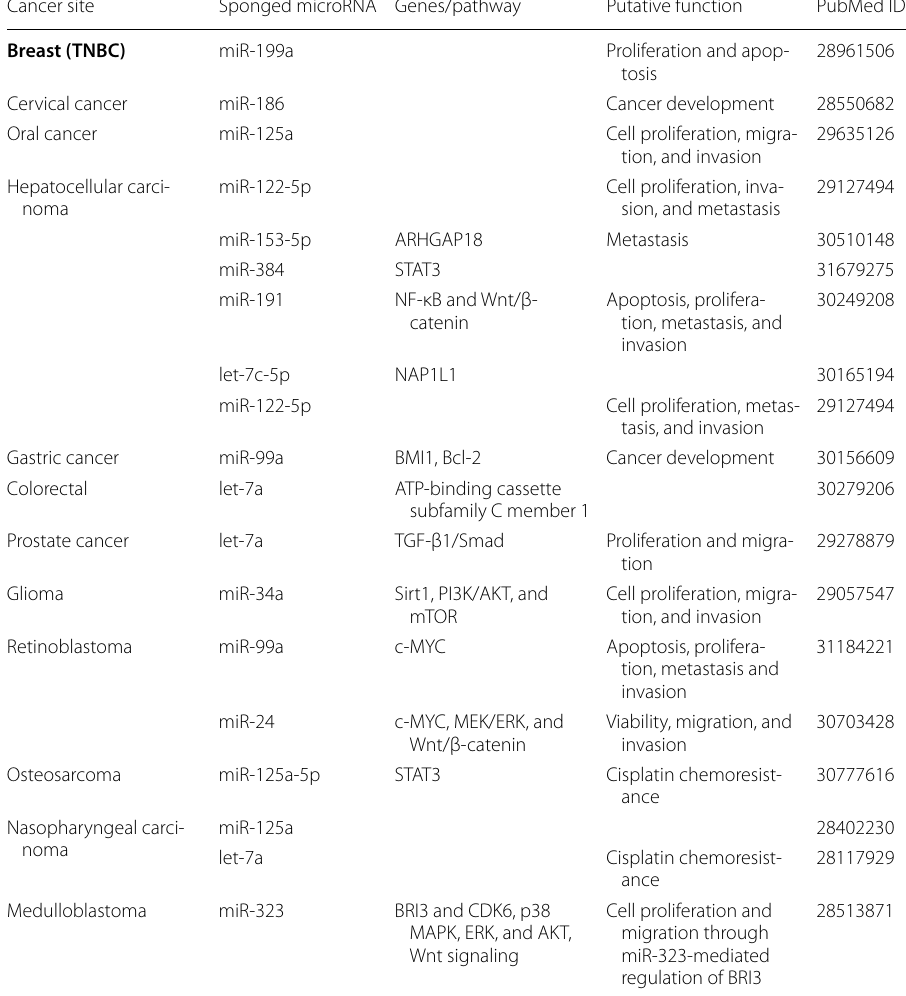
Table 6 Role of CDKN2B-AS1 in microRNA sponging in cancer. Data source : PubMed and NCBI Cancer